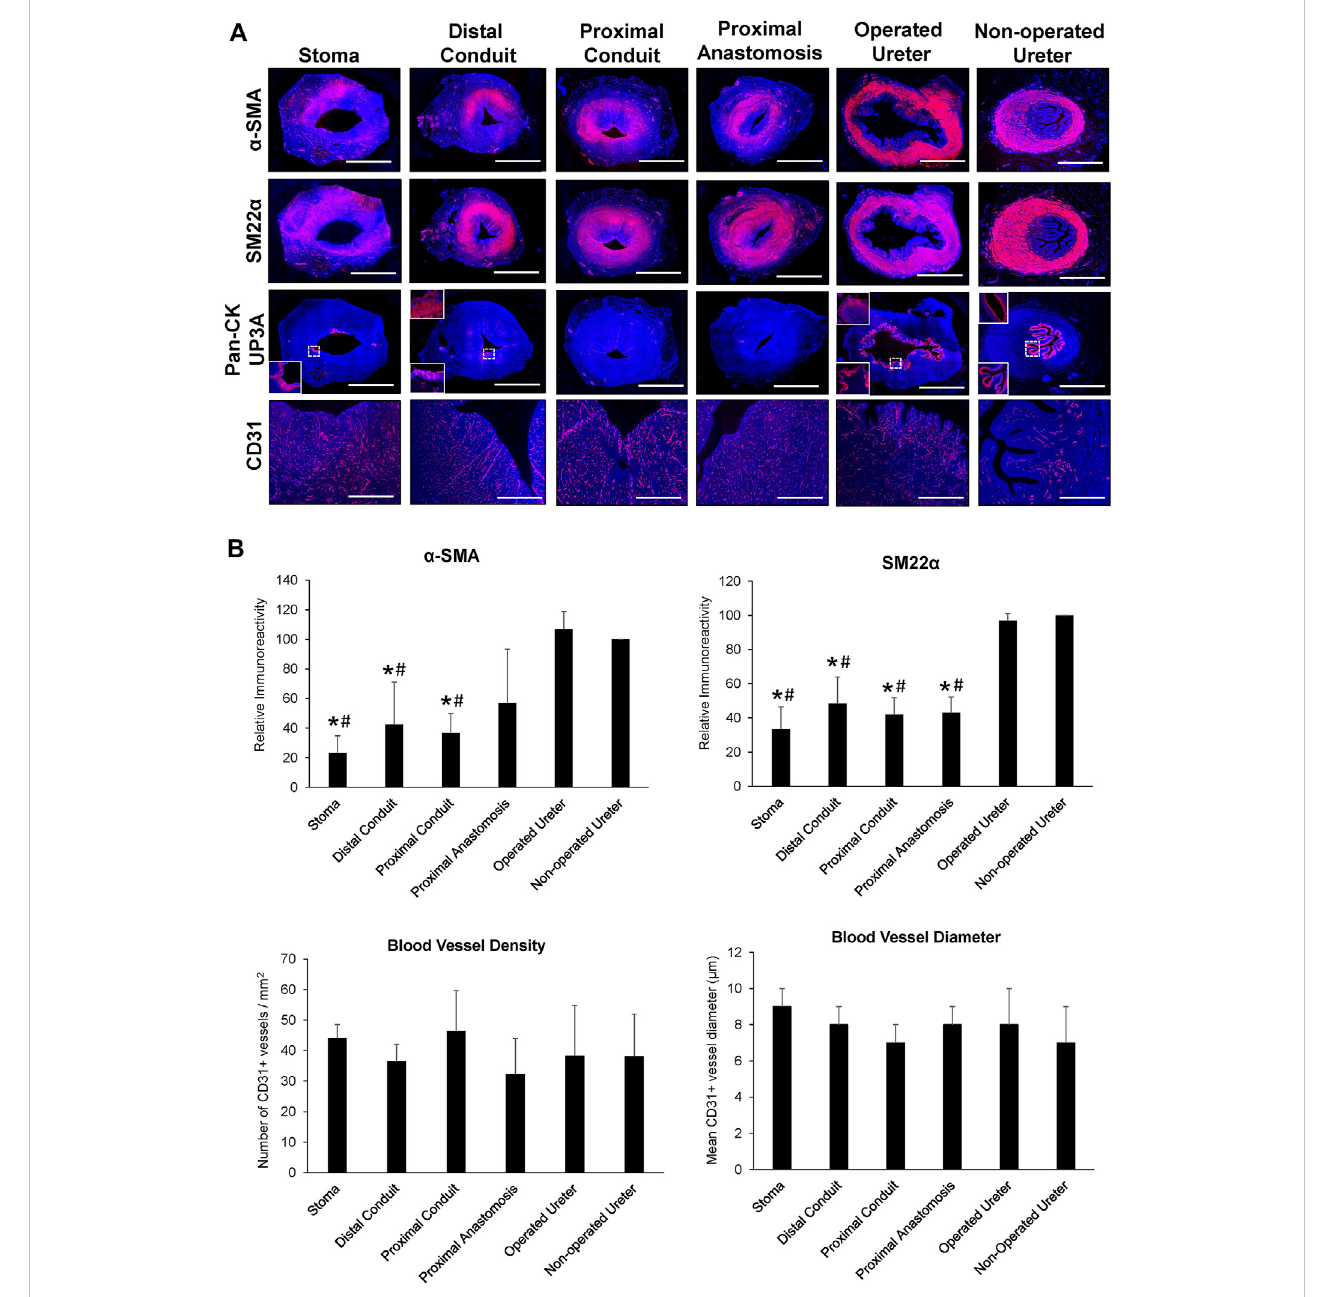
FIGURE 5 Immunohistochemical and histomorphometric analyses of neoconduit maturation. (A) Representative photomicrographs of selective protein expression inneoconduitregions (stoma,proximal/distal conduit,proximalanastomosis) andcontroltissues(operatedandnon-operated ureters)fromPig 3. Markers include smooth muscle contractile proteins ( fi rst and second rows: α -SMA, SM22 α ), epithelial proteins (third row: pan-CK, global images and bottom insetsmagni fi edfromboxedarea;UP3A: topinsets),andvascularendothelial CD31(fourthrow).Forallpanels,respective markerexpressionislabeledin red (Alexa Fluor 594 labeling) with DAPI nuclear counterstain displayed in blue. Scale bars = 1 cm for each panel. α -SMA, a-smooth muscle actin; CK, cytokeratin; DAPI, 4 ′ , 6-diamidino-2-phenyllindole; UP3A, uroplakin 3A. (B) Quantitative evaluations of markers detailed in panel A for Pigs 1 – 5. Data are presentedasmeans±SD.ResultsfromallcohortswereanalyzedwithKruskal – WallisandposthocDunn ’ stests.P 〈 0.05relativetorespectiveoperated(*)and non-operated (#) ureteral